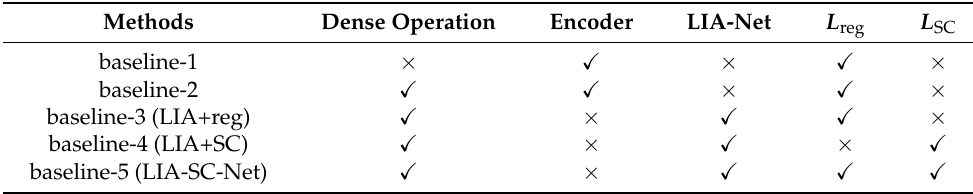
Table 2. Five baselines for the verification of